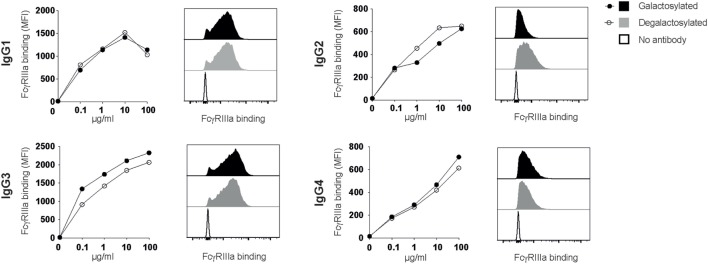
Immunoglobulin gamma (IgG) binding to FcγRIIIa does not require Fc-galactosylation. Binding of galactosylated and degalactosylated IgG isotypes to CHO cells transfected with FcγRIIIa was analyzed by flow cytometry. Binding curves and flow cytometry histograms at 10 µg/ml are shown.